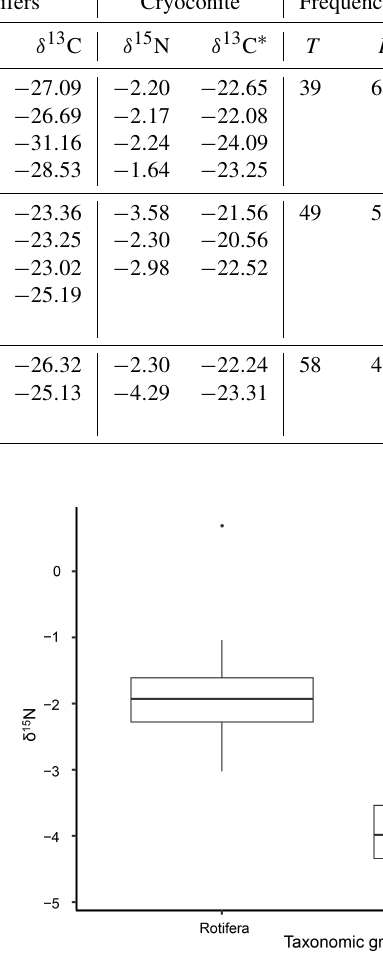
Table 1. Description of samples and isotopic values ( δ 13 C, δ 15 N) of tardigrades, rotifers and cryoconite. Isotopic values are presented in per mille and related to the international standards of the Pee Dee Belemnite for carbon and atmospheric N 2 for nitrogen. The δ 13 C ∗ are values of cryoconite after carbonate removal. The frequency of consumers on each glacier is expressed in percent relative to the total quantity of collected consumers for isotopic analyses. T signifies tardigrades, and R signifies rotifers. Glacier Tardigrades Rotifers Cryoconite Frequency δ 15 N δ 13 C